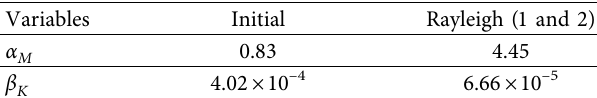
Table 6: Comparison of the parameters of the Rayleigh damping model before and after updating for case